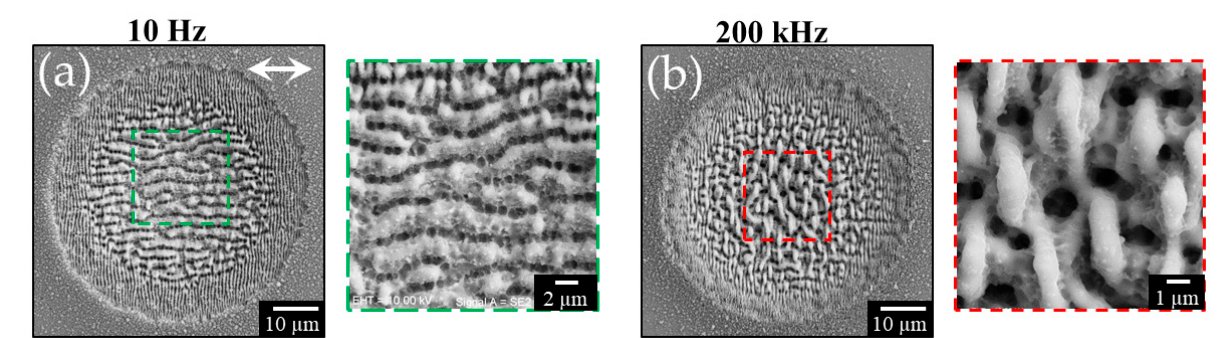
Figure 9. Examples of SEM images of a silicon target irradiated with a sequence of N = 200 laser pulses at a peak fluence of ≈ 0.5 J/cm 2 for repetition rates of ( a ) 10 Hz and ( b ) 200 kHz. The white arrow in panel ( a ) schematically indicates the direction of the linear polarization. The insets on the right of each SEM images reports views of the area in the dashed, colored box registered at higher magnification.